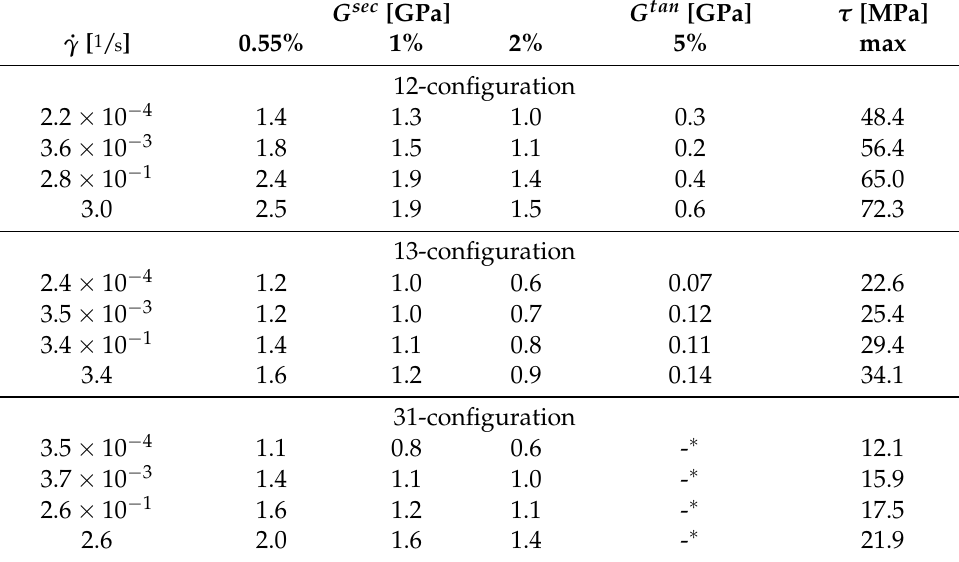
Table 2. Characteristic strain rate dependent shear modulus and maximum